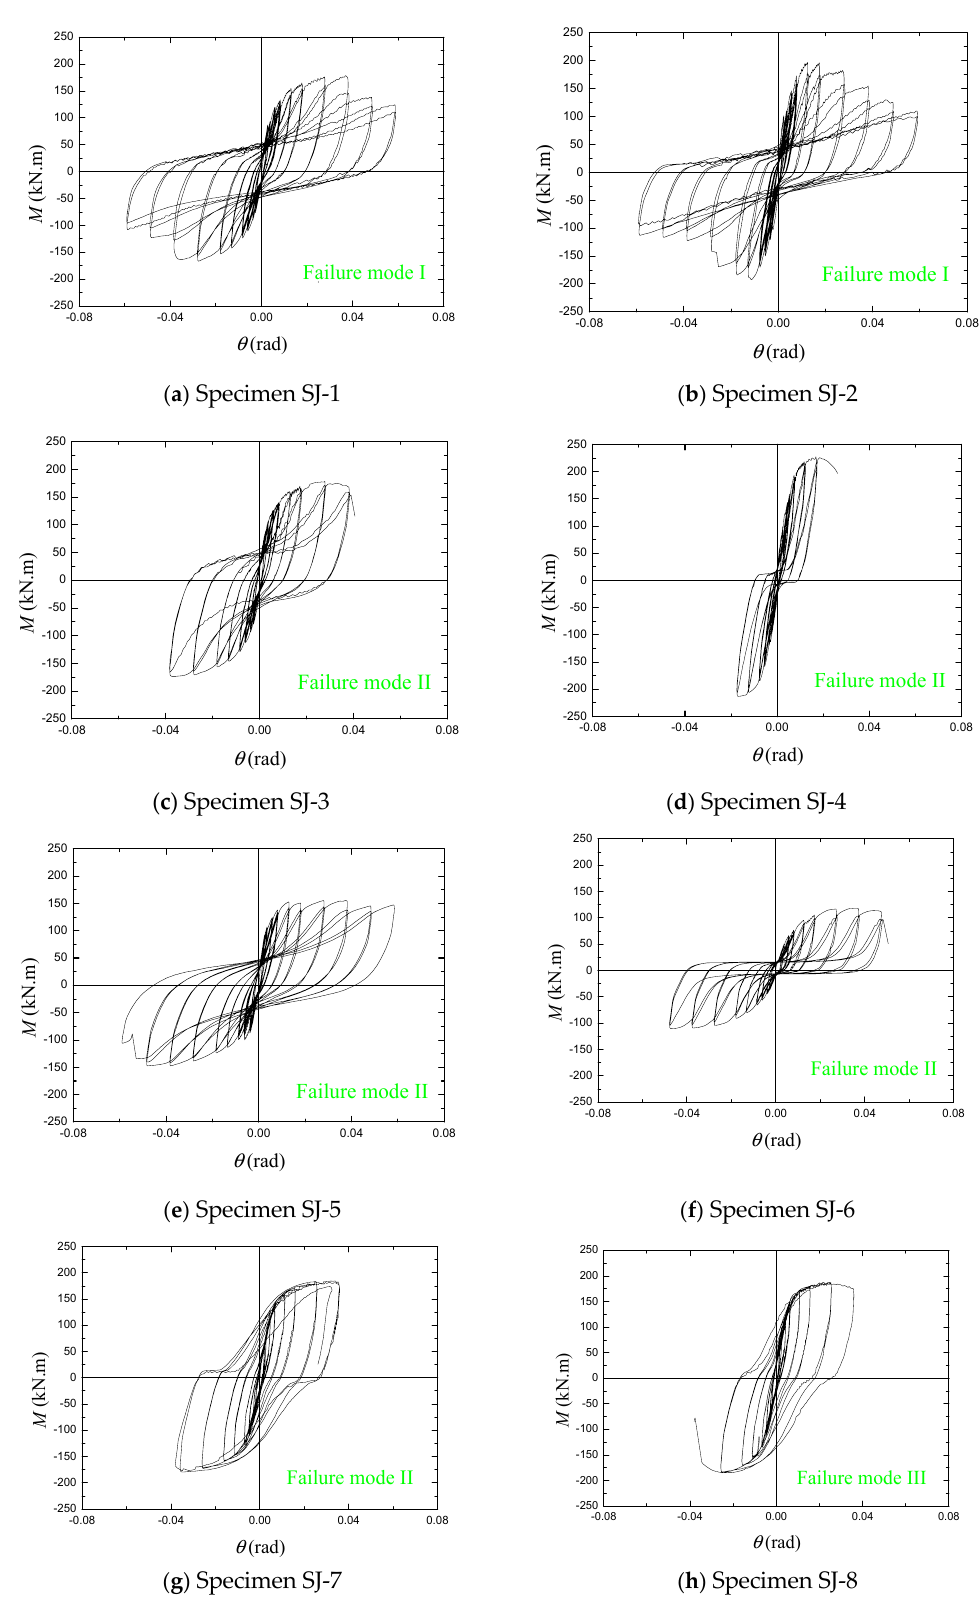
Figure 13. Moment ( M ) versus rotation ( θ ) hysteresis curves of the